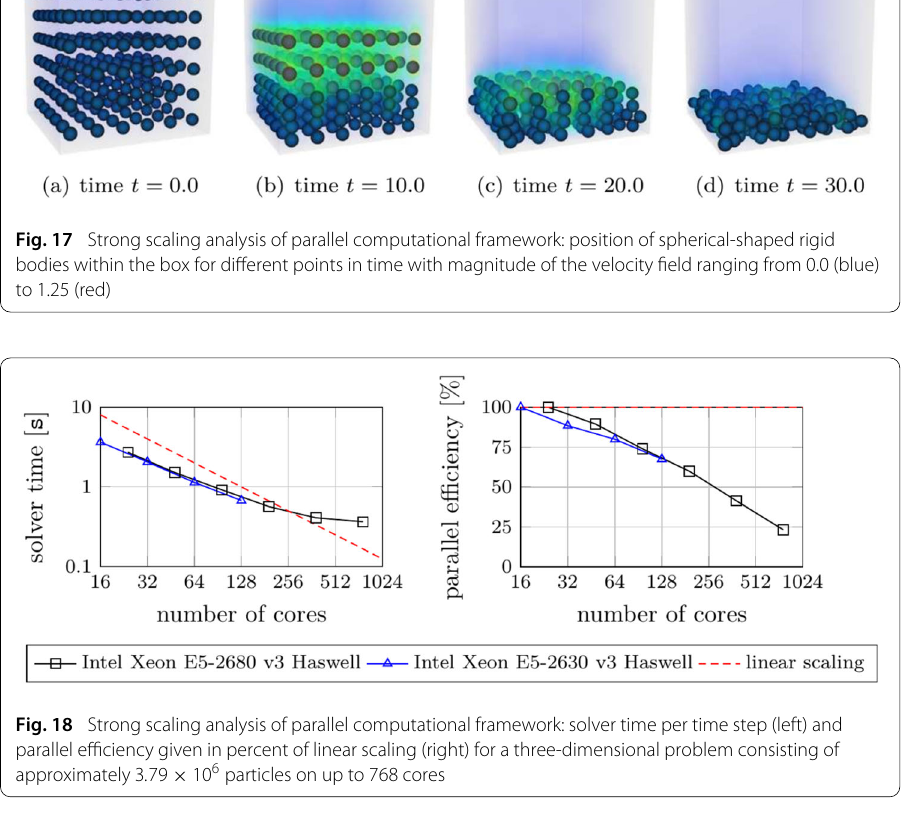
observed after t ≈ 5 . 0. The rigid bodies begin piling up at the bottom wall of the box and are nearly at rest at t = 30 .